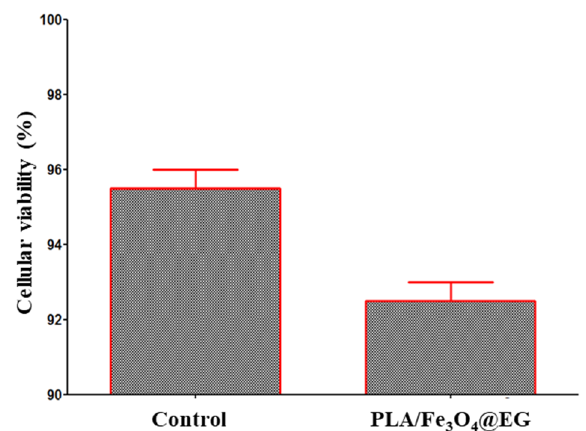
Figure 10. Viability results of human amniotic fluid-derived mesenchymal stem cells (AFSCs) incubated for 72 h in the presence of PLA/Fe 3 O 4 @EG coatings.